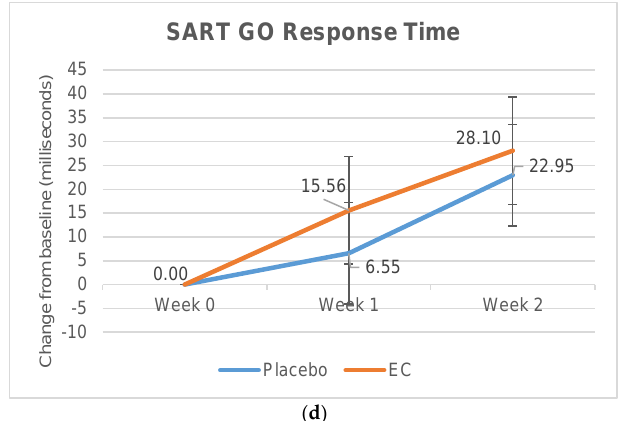
Figure 4. ( a ) Stroop reaction time—congruent; ( b ) Stroop reaction time—incongruent; ( c ) SART % NO-GO Success; and ( d ) SART GO Response Time. Estimated change in Stroop and SART test parameters ( ± standard error) with statistically significant visit effects at Weeks 1 and